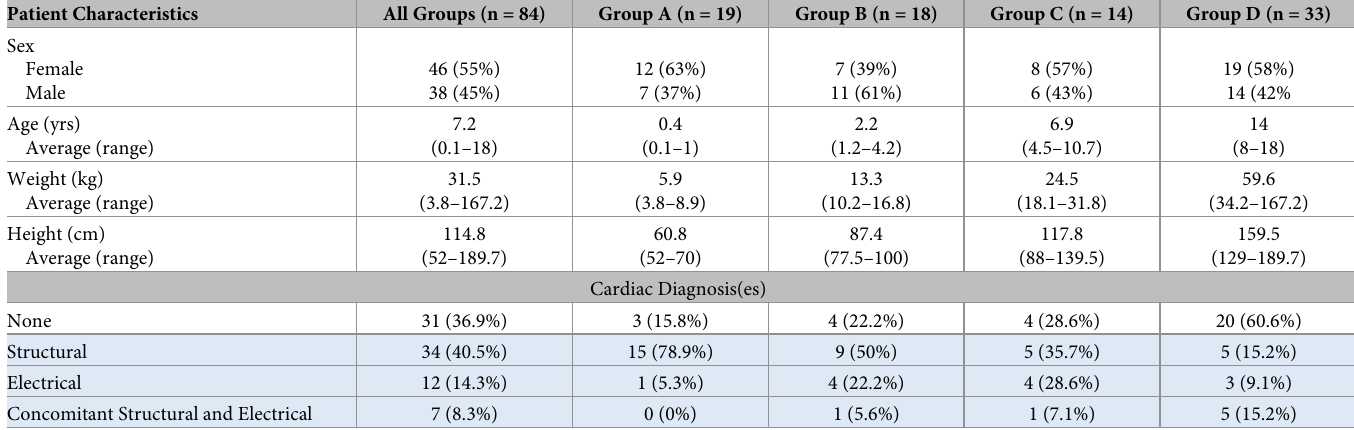
Table 1. Demographic data. Patient demographic data is shown. Diagnoses in this table were part of the patients’ known history before study data was obtained. Struc- tural diagnoses included: Coarctation of the aorta, cardiomyopathy, single ventricle physiology, multisystem inflammatory syndrome in children (MIS-C) and coronary artery anomaly, orthotopic heart transplant (OHT), pulmonary hypertension, rhabdomyoma, tetralogy of Fallot (TOF), ventricular septal defect (VSD), atrial septal defect (ASD), patent ductus arteriosus (PDA), or atrioventricular (AV) canal defect. Electrical diagnoses included: Supraventricular arrhythmias, AV block, catecholamine poly- morphic ventricular tachycardia (CPVT), long QT syndrome, or premature atrial/ventricular conductions. Concomitant structural and electrical diagnoses included: Dou- ble outlet right ventricle and SVT, MIS-C + coronary artery anomaly and AV block, OHT and atrial flutter, TOF s/p pacemaker, cardiomyopathy s/p pacemaker, congenitally corrected transposition of the great arteries s/p pacemaker, and TOF and Wolff-Parkinson-White. Patient